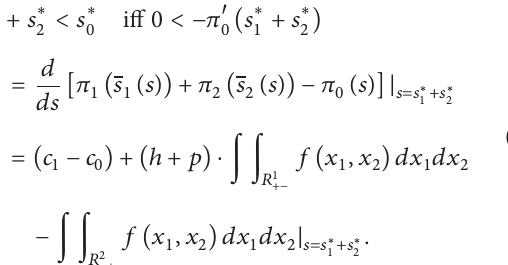
Figure 3: Domains separating function 𝑓(𝑥 1 , 𝑥 2 ) ( 𝑠 is